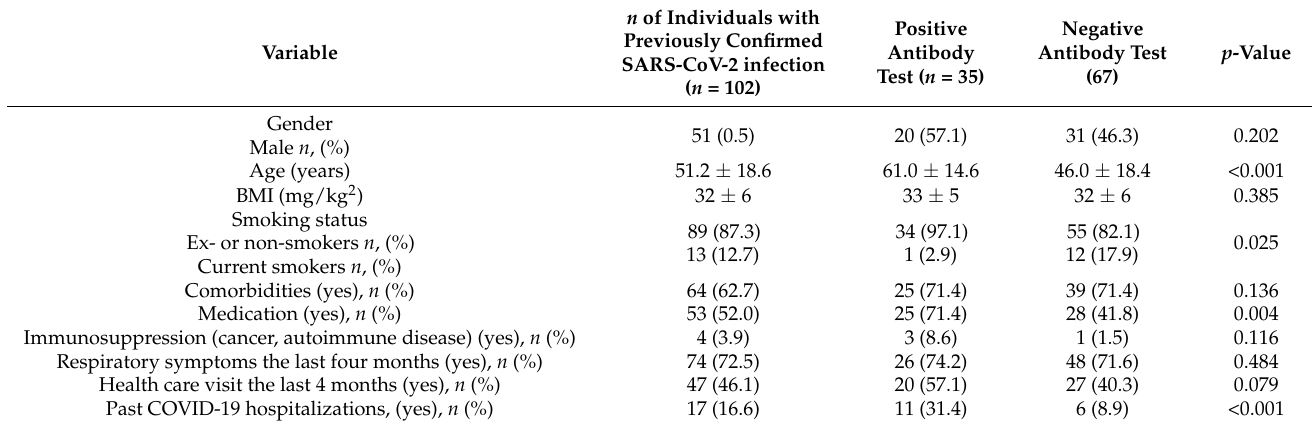
Table 2. Characteristics of the patients with previously confirmed SARS-CoV-2 infection who tested positive in comparison with those tested negatives for virus antibodies, n =